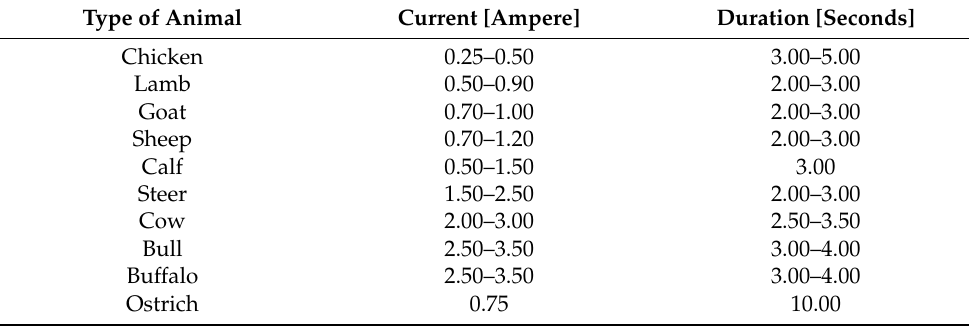
Table 3. Guideline parameters for electrical